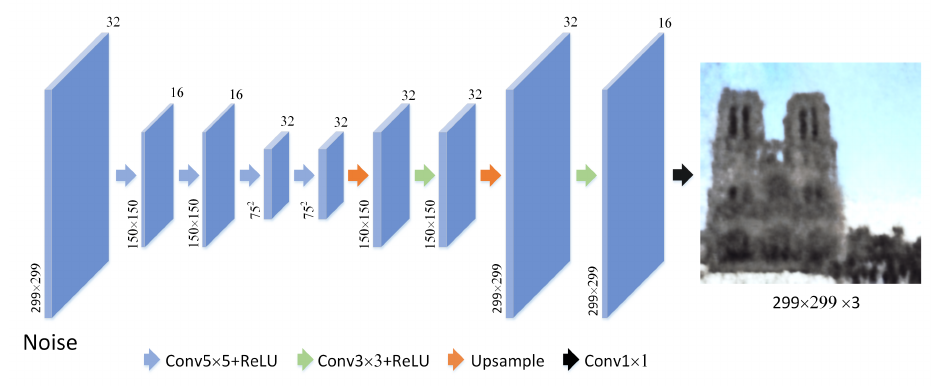
Figure 4. The structure of the network DIP 1 .